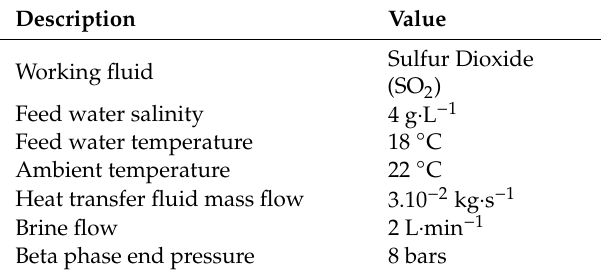
Table 5. Process operating and control